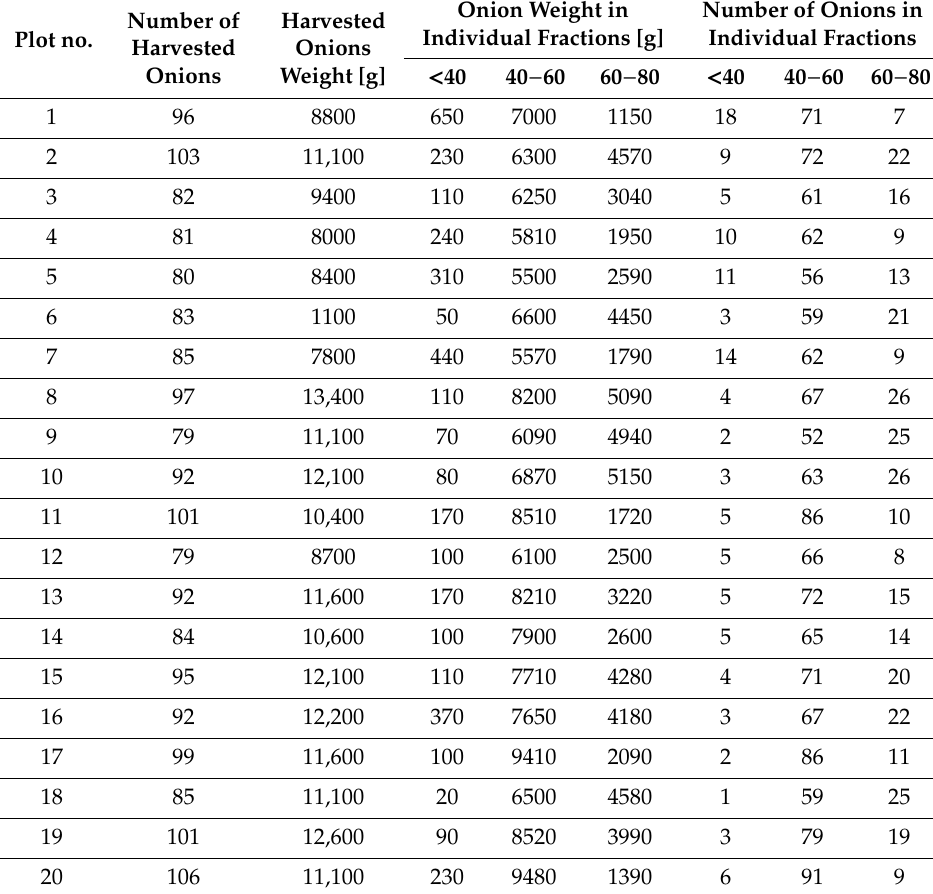
Table 3. Detailed data obtained in the